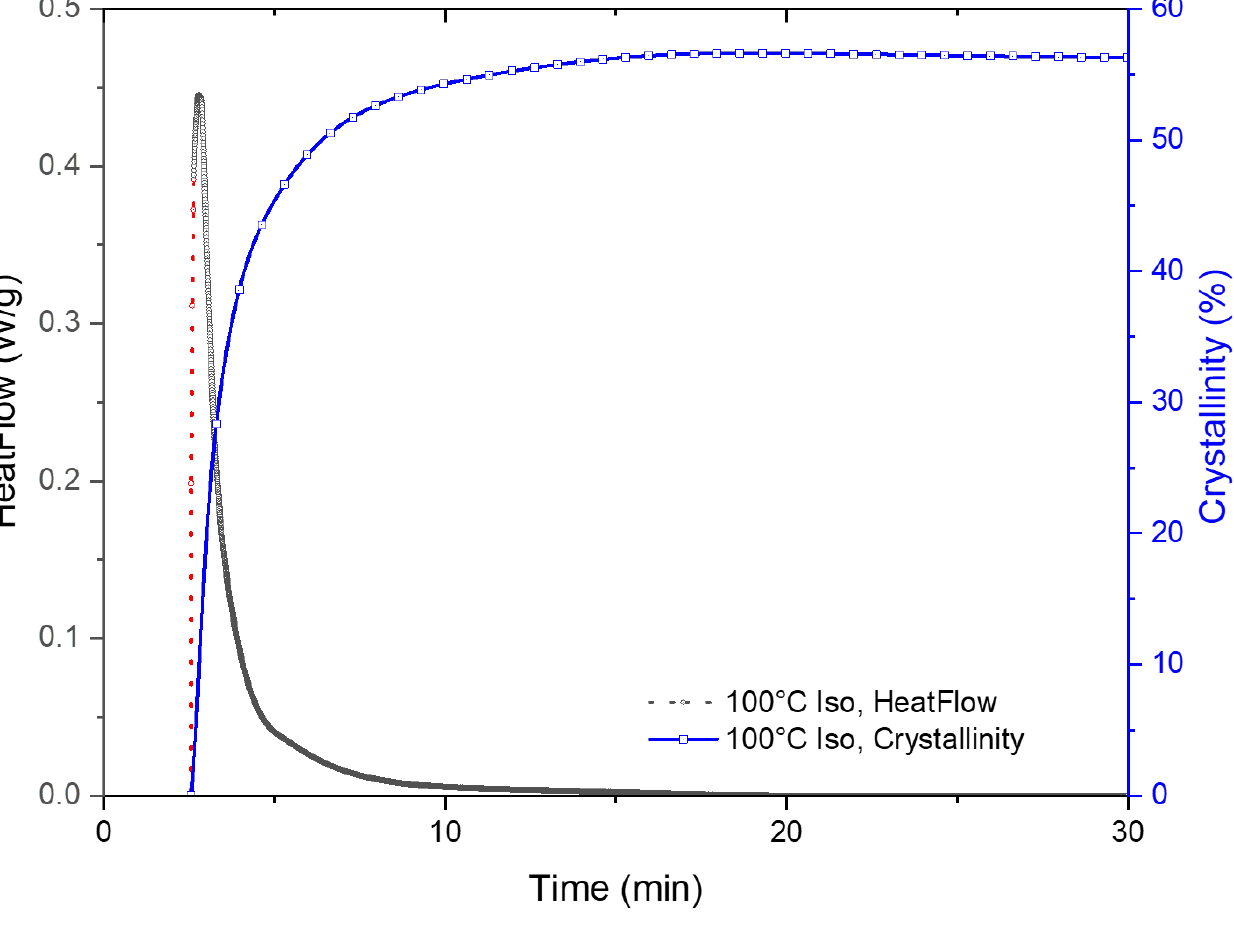
Figure 5. DSC curve after replacing unreliable data with fitted data. The experimental data is shown in black, and the computed data from curve fitting is presented in red. The blue curve shows the cumulative heat flow calculated by integrating the hybrid DSC isotherm curve.